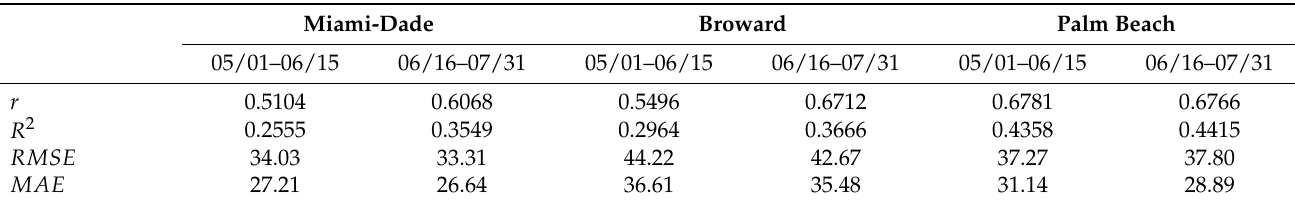
Table 6. Random forest model performance for 05/01–06/15/2020 and 06/16–07/31/2020 for Miami-Dade, Broward, and Palm Beach